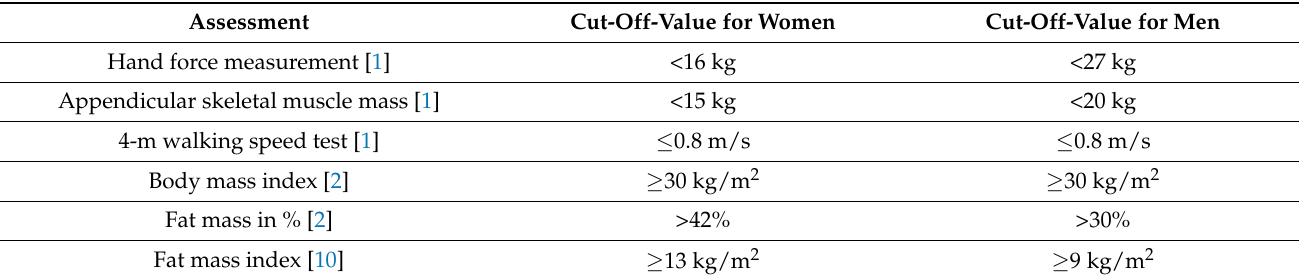
Table 1. Sex-specific cut-off values for SO